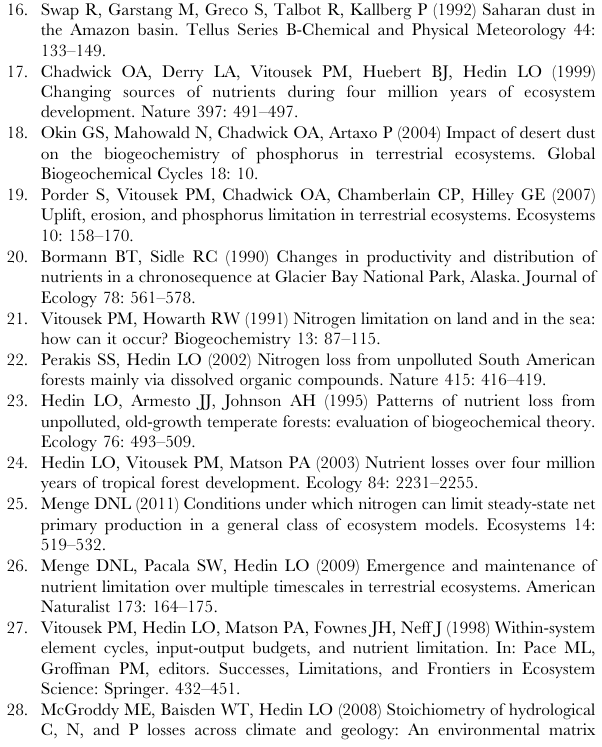
Figure S1 Examples of transient dynamics at the short timescale. (A) Litter N approaches its quasi equilibrium in a saturating manner with a rate controlled by the exponent in equation S2 in Appendix S1. Litter P would be qualitatively similar. Depending on whether the perturbation increases (e.g., a storm that blows leaves down) or decreases (e.g., a ground fire) litter stocks, the saturation will approach from above or below. Short timescale litter dynamics do not depend on which nutrient limits plant growth. (B) Limiting plant-available nutrient dynamics if limitation does not switch on the short timescale. If plant uptake is faster than litter decomposition there are two separate